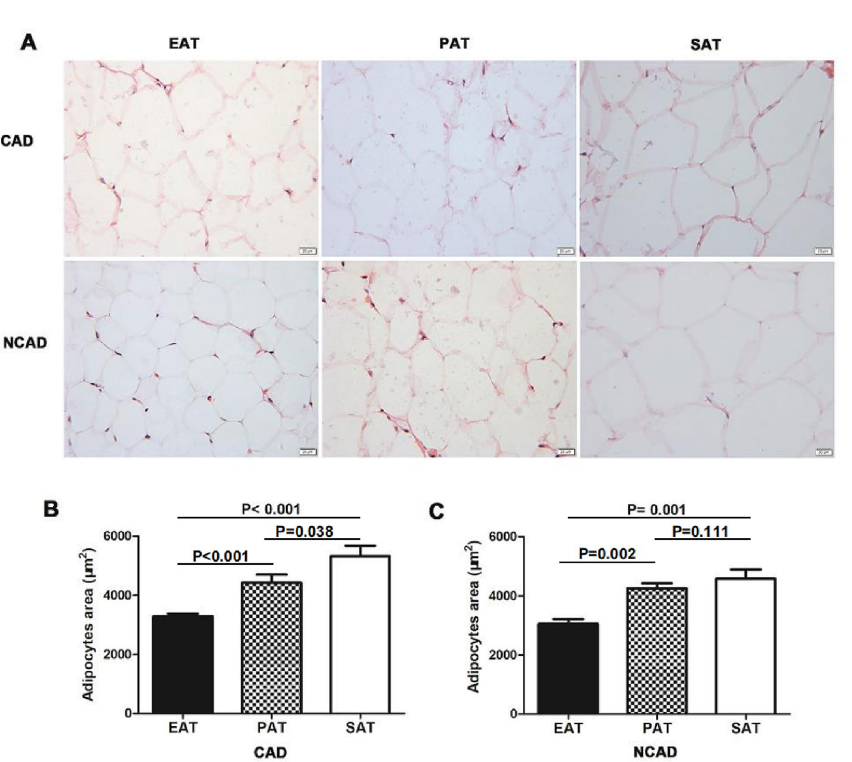
Figure 4. The adipocytes area of EAT, PAT and SAT. ( A ) Representative images of adipocytes area of EAT, PAT and SAT in CAD (n = 20) and NCAD group (n = 12). ( B ) Quantitative analyses of adipocytes area between EAT, PAT and SAT in CAD group (n = 20). ( C ) Quantitative analyses of adipocytes area between EAT, PAT and SAT in NCAD group (n = 12). The Mann–Whitney U test was used to compare the relationship between the CAD and NCAD